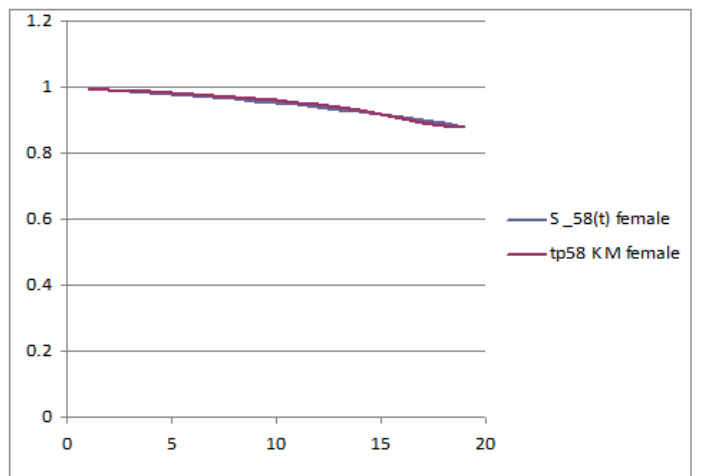
Figure 3. Females, young